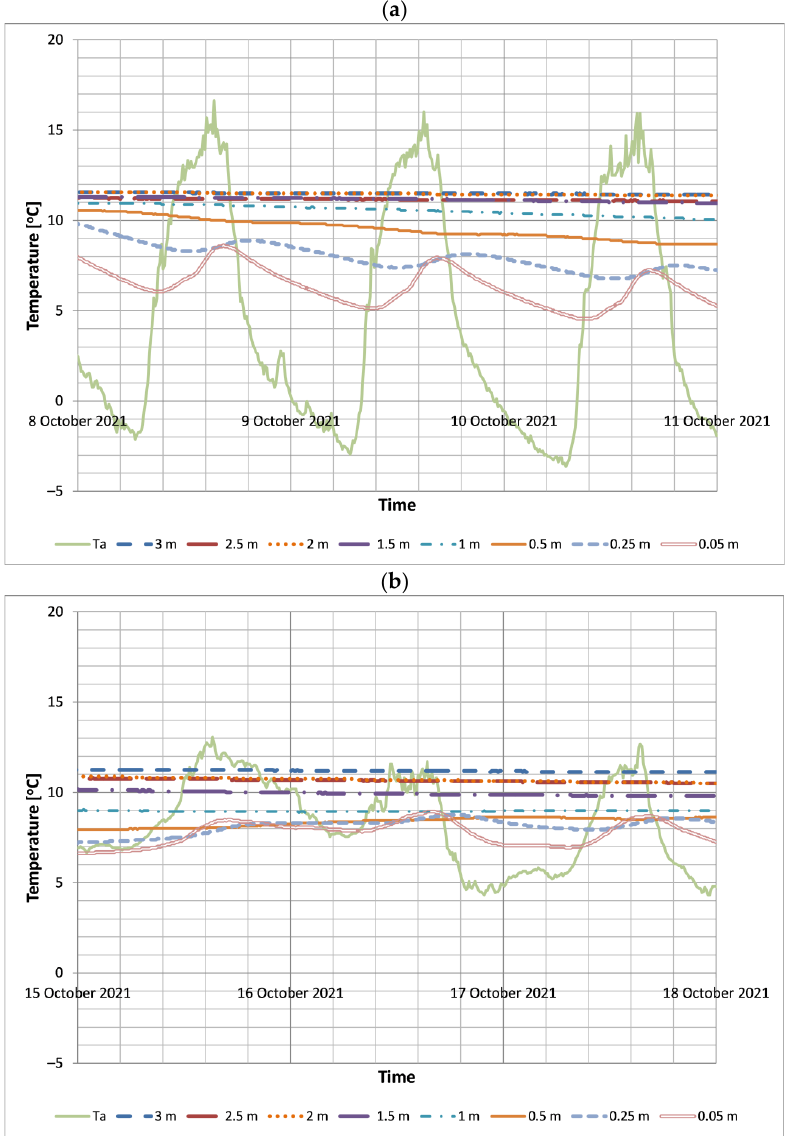
Figure 7. The daily evolution of the temperatures in the ground of point No. 2 for the diurnal temperature ranges: ( a ) T a = 20 °C, ( b ) T a = 8 °C. The average annual soil temperature for the h range from 0.25 to 3.00 m in the case of the measurement point No. 3 is 19.03 °C, while in the case of the measurement points No. 1 and No. 2, these temperatures are, respectively, 10.3 and 10 °C. In the case of meas- urement points No. 1 and No. 2, the values of annual average temperatures are similar despite the presence of different soil. In the case of measurement point No. 3, the annual average temperature values are about twice as high compared to points No. 1 and No. 2, which is caused by the location of the third measurement point in the subtropics. The annual average temperature values at the measurement point No. 3 are similar to the temperature values in the city of Huelva [41], which has the same climatic zone.